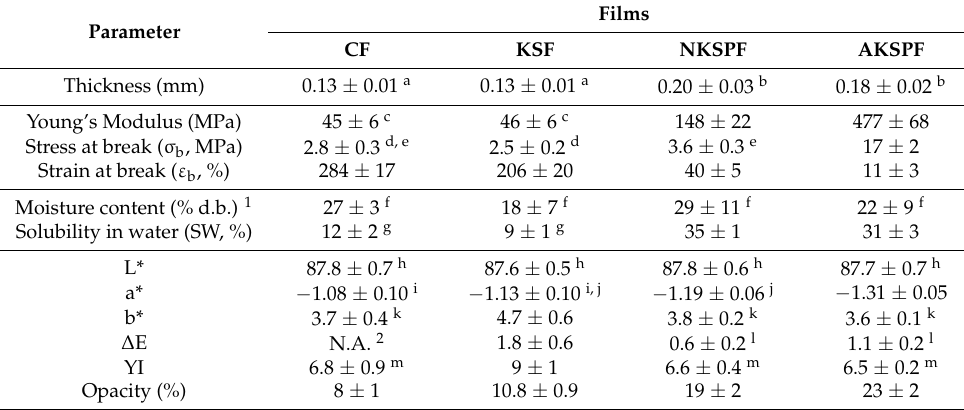
Table 1. Thickness, mechanical parameters, moisture content, solubility in water and color of films: CF (without KS), KSF (added with KS that was not retained in particles), NKSPF (added with KS retained in starch nanostructured particles) and AKSPF (added with KS retained in acetylated starch nanostructured